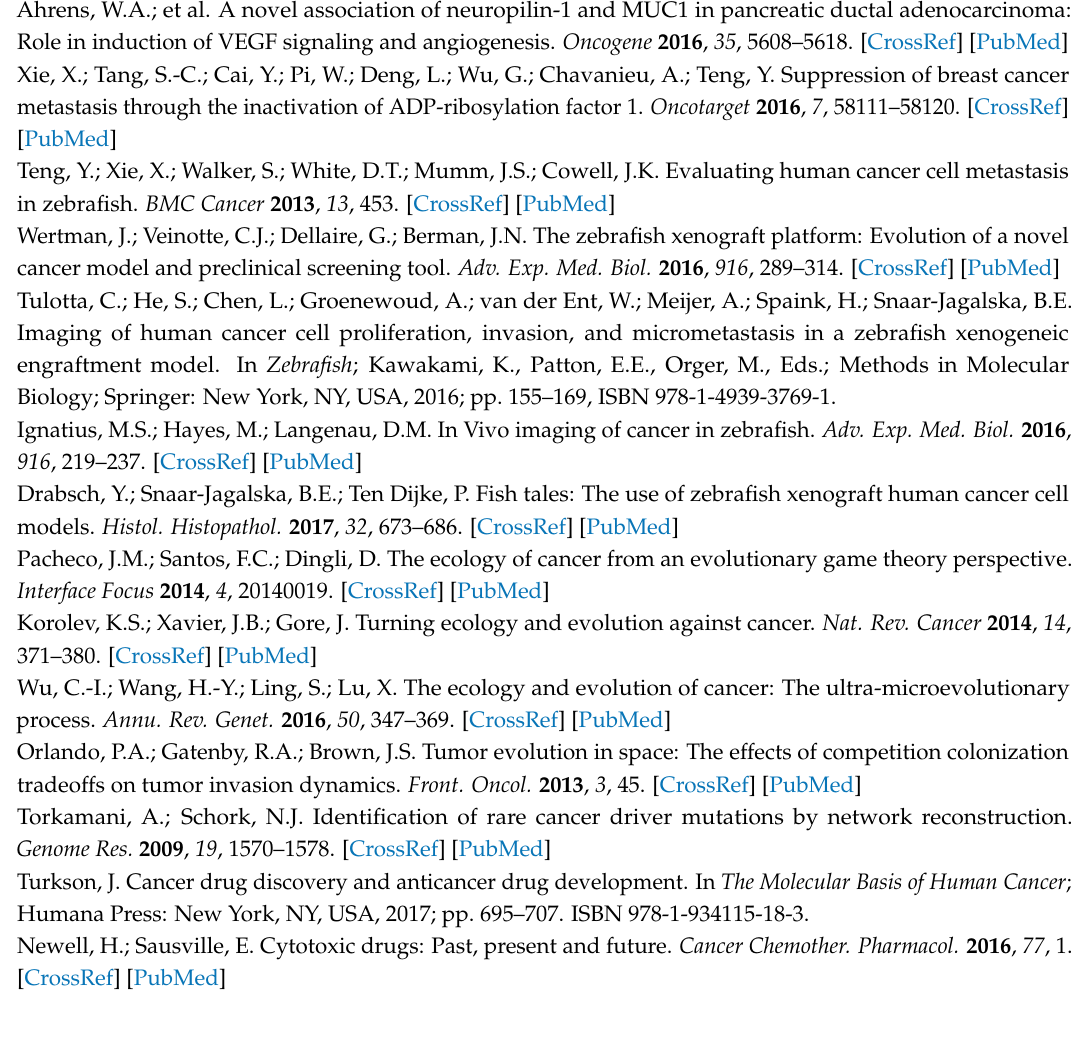
Table S1: Keyword searches and literature survey counts by year for Figure